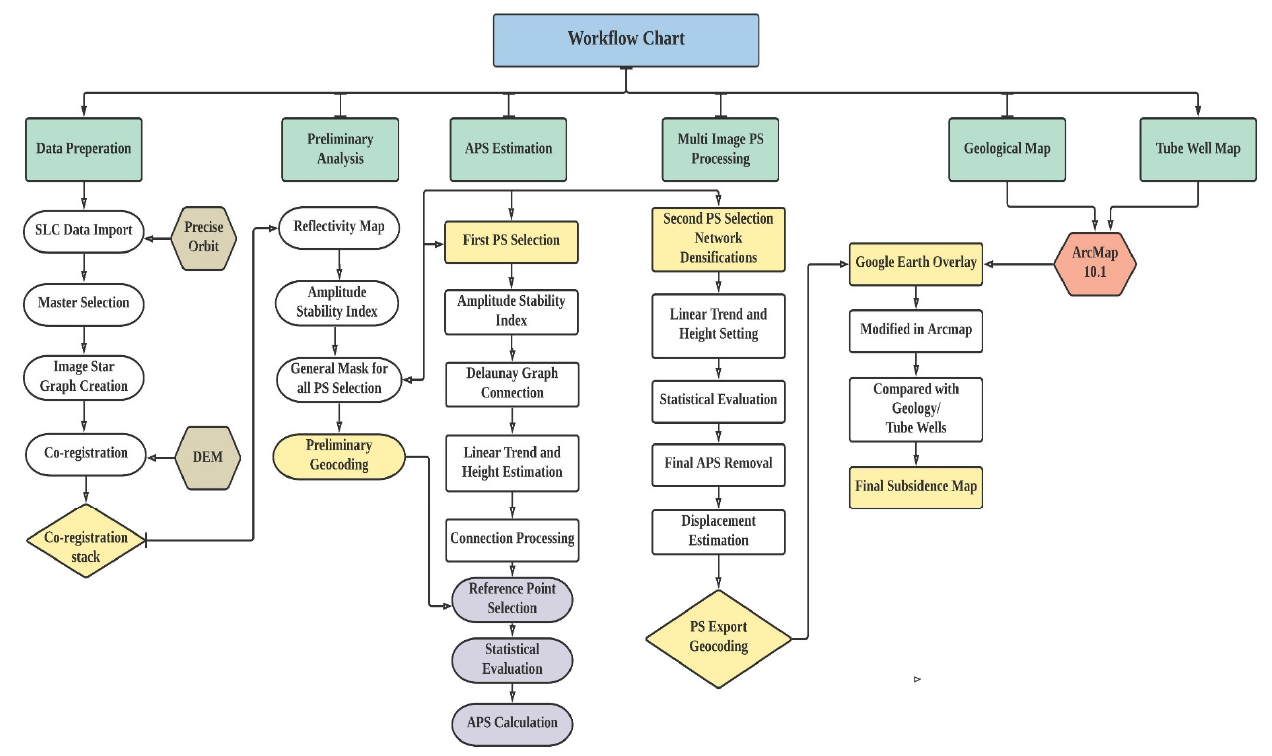
Figure 3. Simplified methodological processing steps.